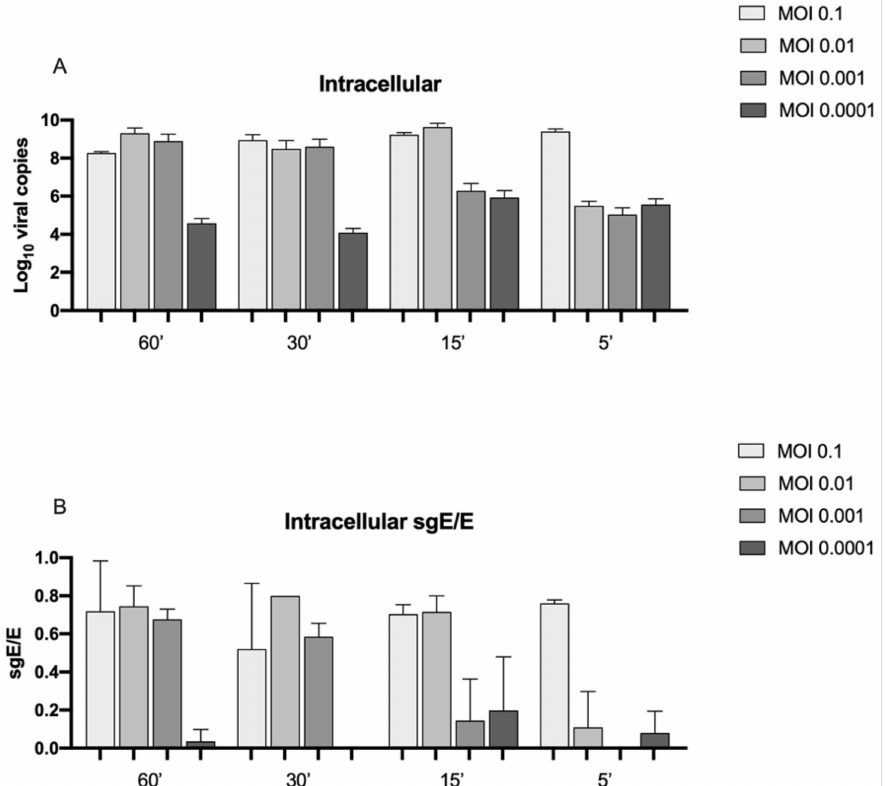
Figure 2. The intracellular RNA viral load. ( A ) Intracellular viral load for N gene (expressed as Log10 RNA viral copies) at 7 days post infection at the different MOI (0.1, 0.01, 0.001, and 0.0001) and time of absorption (60, 30, 15, and 5 min). ( B ) Intracellular ratio of subgenomic E RNA viral copies (Log 10 )/genomic E RNA viral copies (Log 10 ).